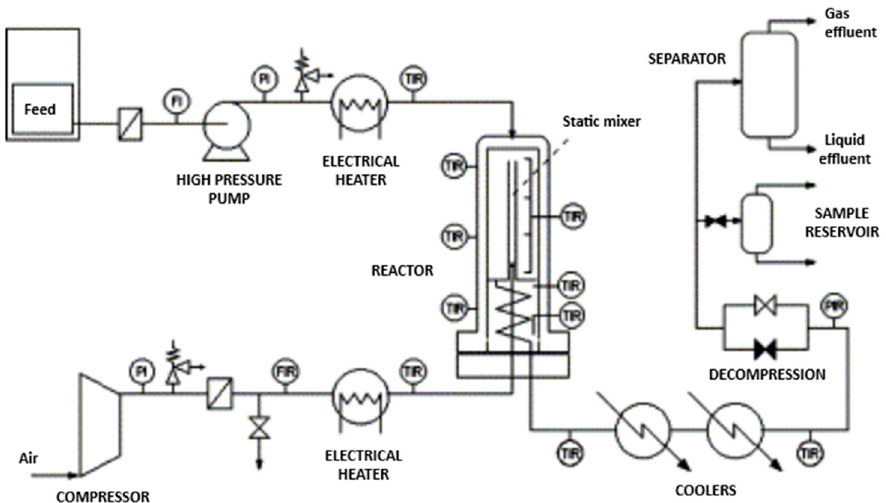
Figure 13. Sketch of an SCWO pilot plant. Adapted with permission from [157]. Copyright © 2002 Elsevier.